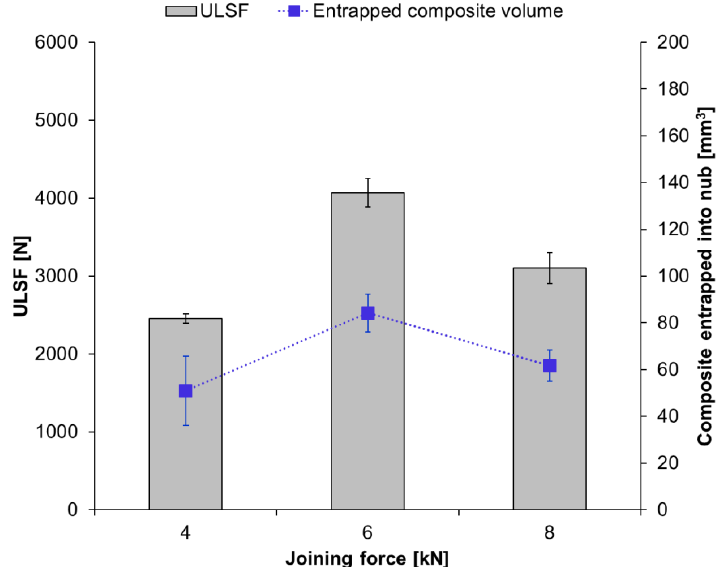
Figure 7. A representative example of the fracture surface of a friction spot joint. The arrows indicate the layer of the reconsolidated molten PPS.